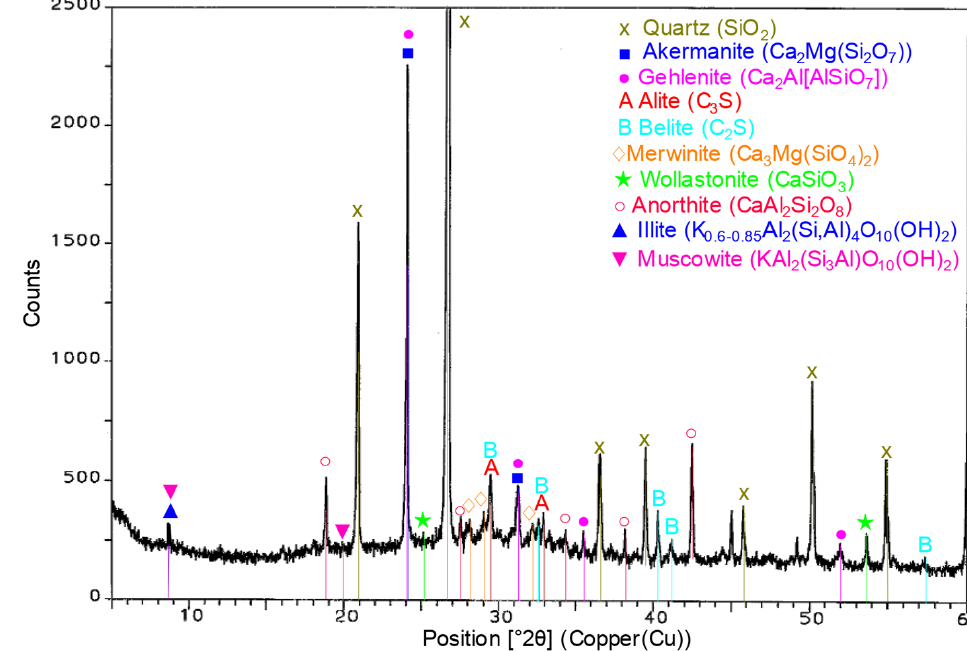
Figure 14. XRD RPC + 60% EP after 28 days of curing.